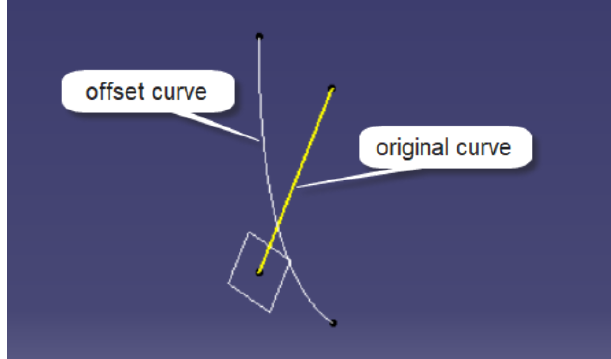
Fig. 10 3D modelling design of curved parts.